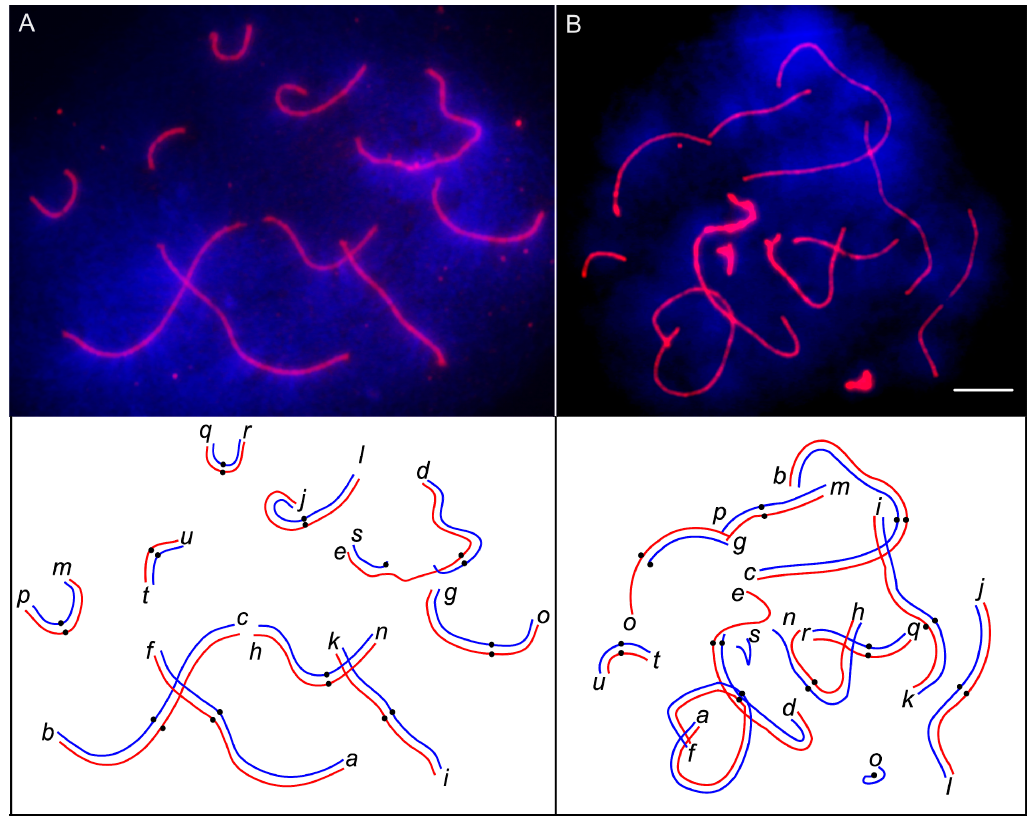
Figure 2. Fluorescent micrographs and interpretative diagrams of pachytene spermatocytes of a normal homozygote ( A ) and a CIII ( g/o ) heterozygote ( B ) after immunolocalisation of SYCP3 (red) and DAPI counterstaining (blue). Centromeres are marked with black circles on the diagrams. Letters indicate distal ends of the chromosome arms. Scale bar: 5 µm.